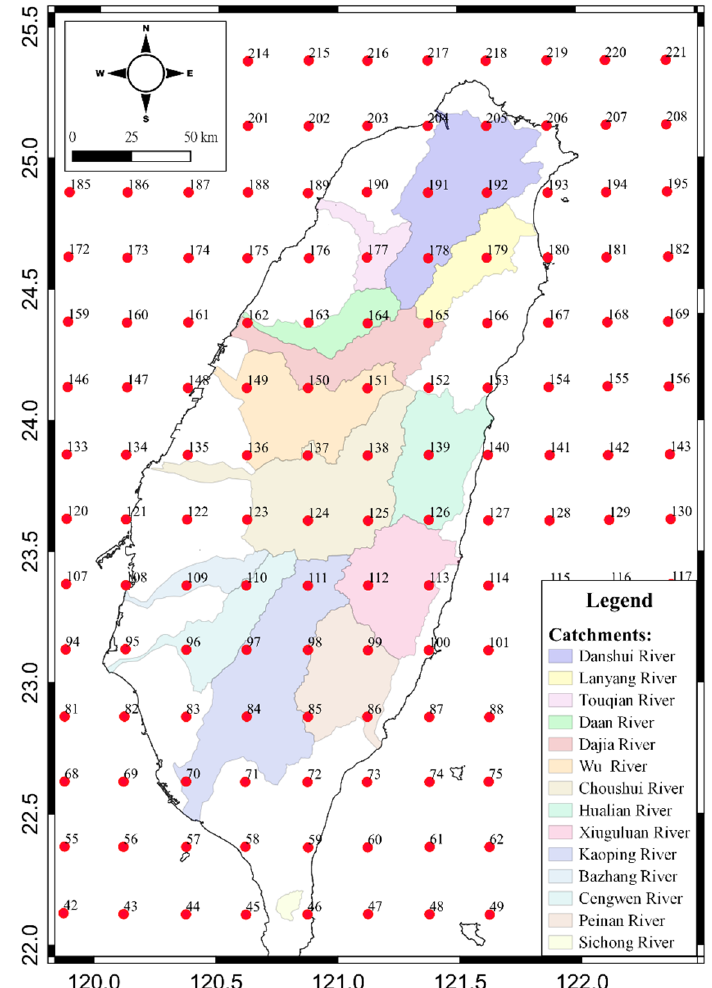
Figure 3. Adopted river catchments and 25 km × 25 km grid distribution (red points) for the climate scenarios given by the TCCIP. The numbers beside the red dots are the data number provided by the TCCIP (data from National Science and Technology Center for Disaster Reduction, NCDR).